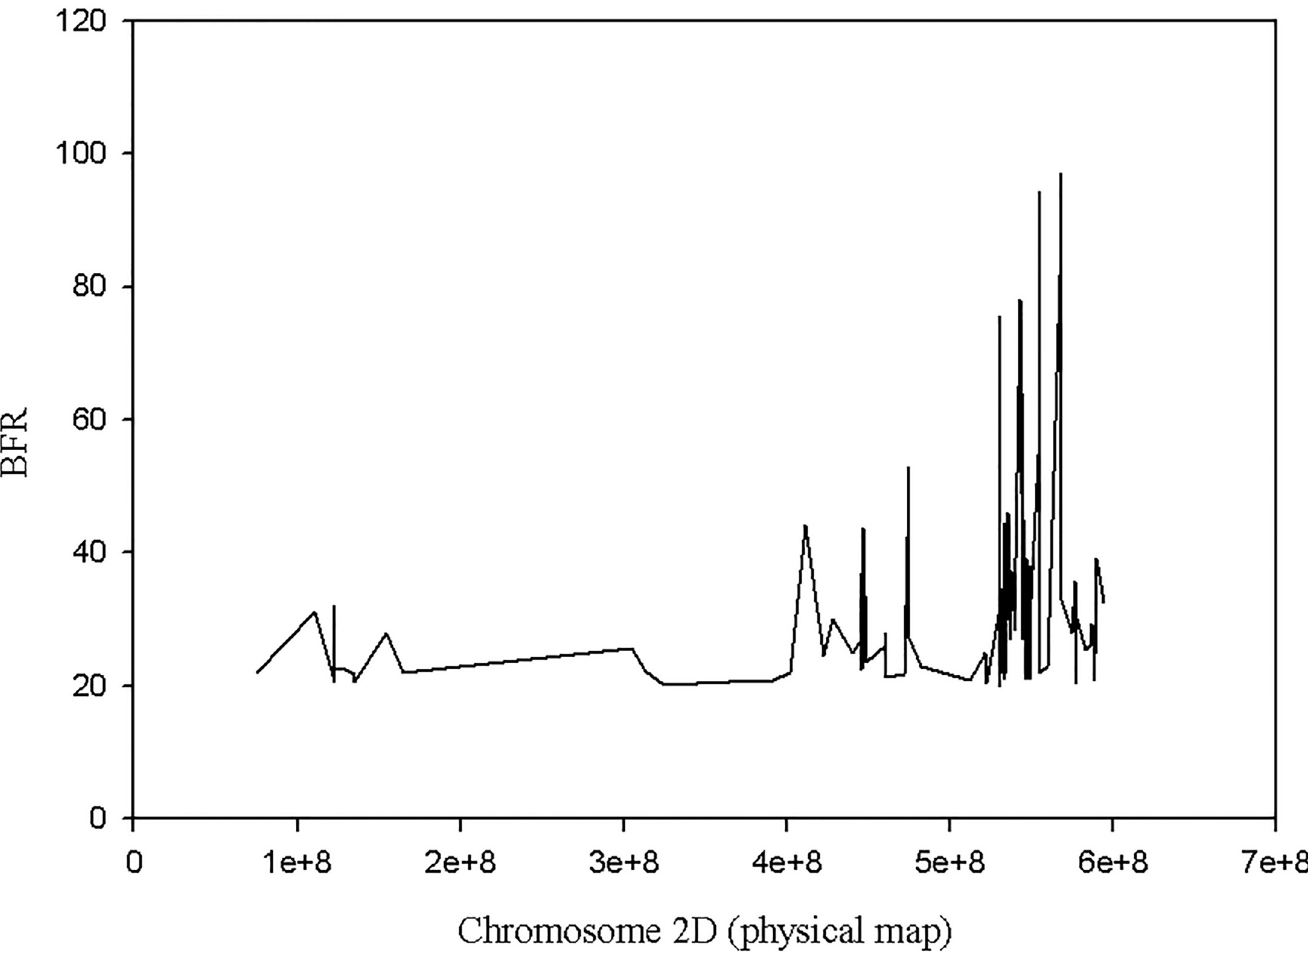
Fig 7. Distribution of SNPs with NLR domain on chromosome 2D of Ae . tauschii chromosome.